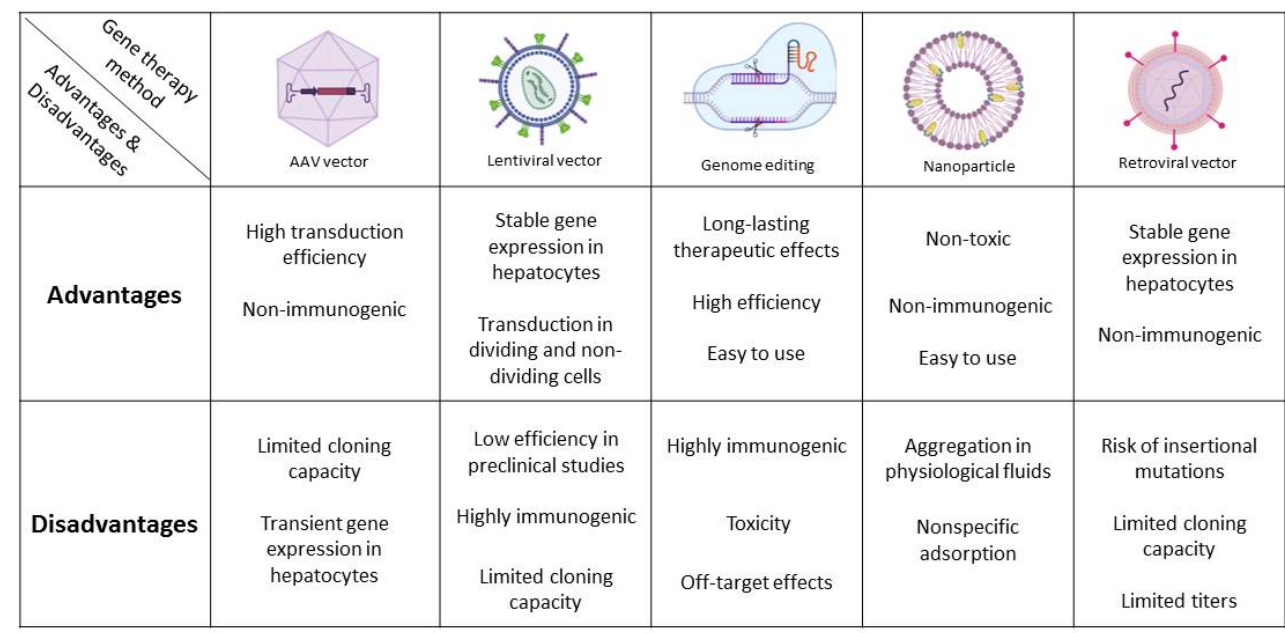
Figure 2. The advantages and disadvantages of common gene delivery methods in monogenic liver disorders. The figure was created with Biorender (www.biorender.com (accessed on 21 June 2022)). Table 2. Gene-therapy-based clinical trials in monogenic liver